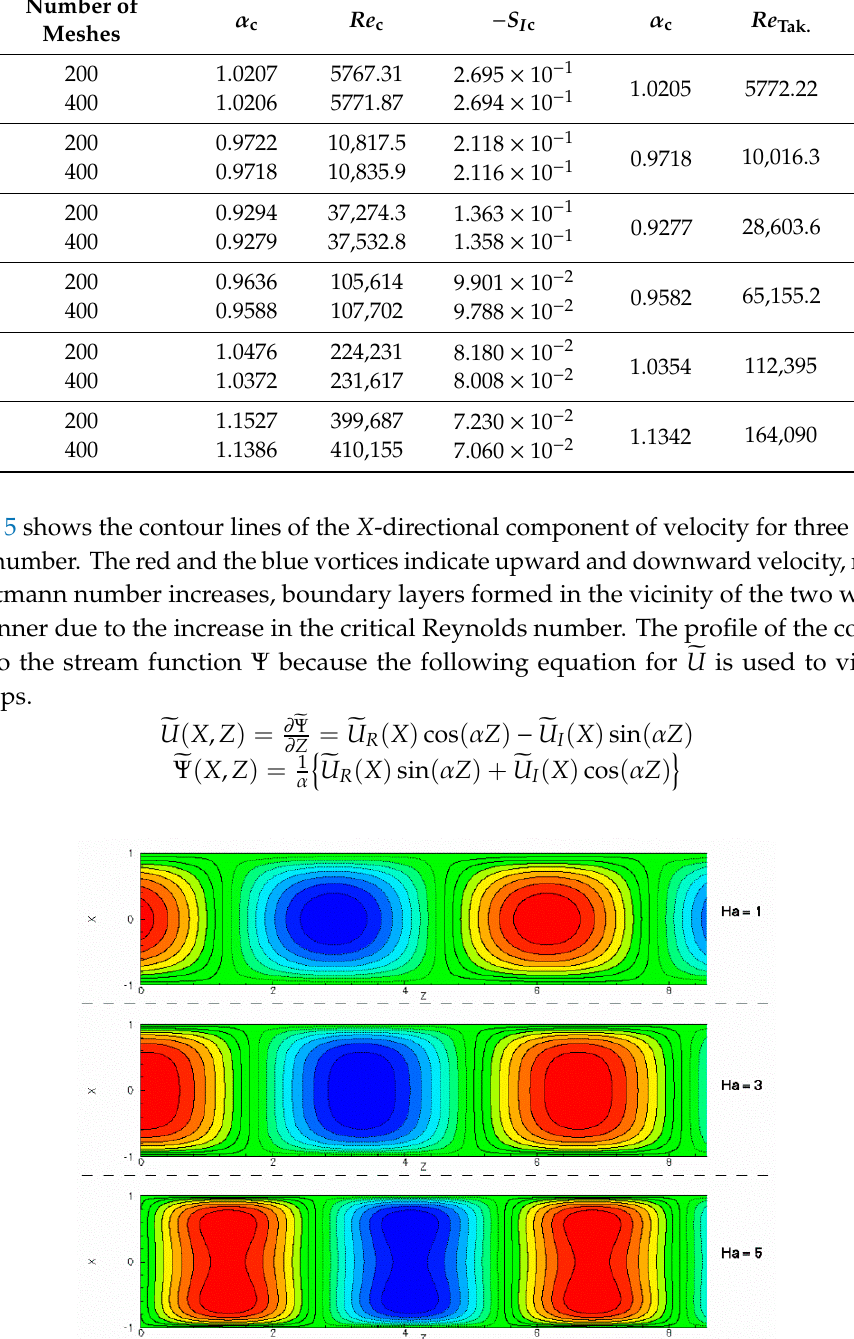
Figure 5. The contour lines of the X -directional component of velocity at the critical state for Ha = 1, 3, and 5. The computational conditions of wavenumber, Reynolds number, and angular frequency are as listed in Table 2.